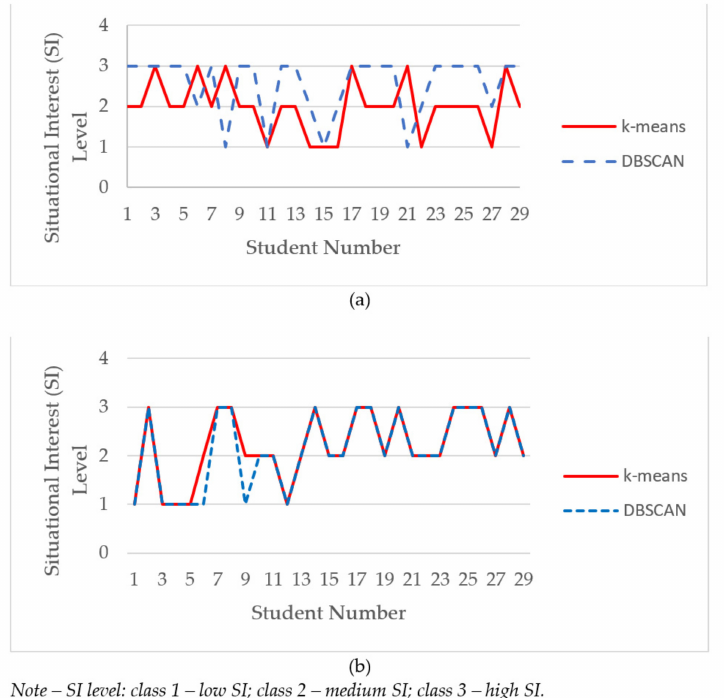
Figure 7. The SI level classified for the same student with different approaches. ( a ) Both algorithms show a difference; ( b ) both algorithms show an agreement. Table 5. Average speed of the applied clustering. EEG